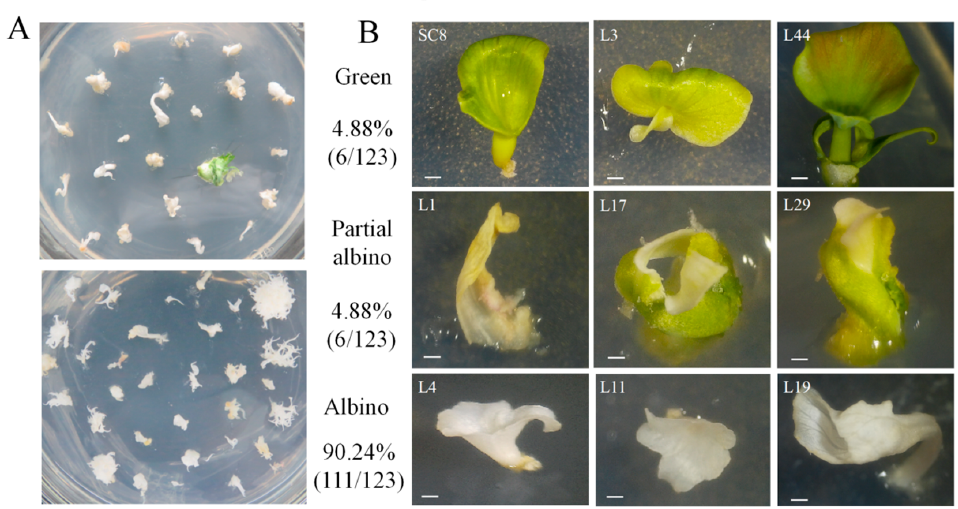
Figure 8. Phenotypes of the regenerated cotyledons after MePDS gene editing. ( A ) Regenerated cotyledons on CEM medium. ( B ) Phenotypic diversity of CRISPR/Cas9-induced MePDS mutations in cassava cotyledons.